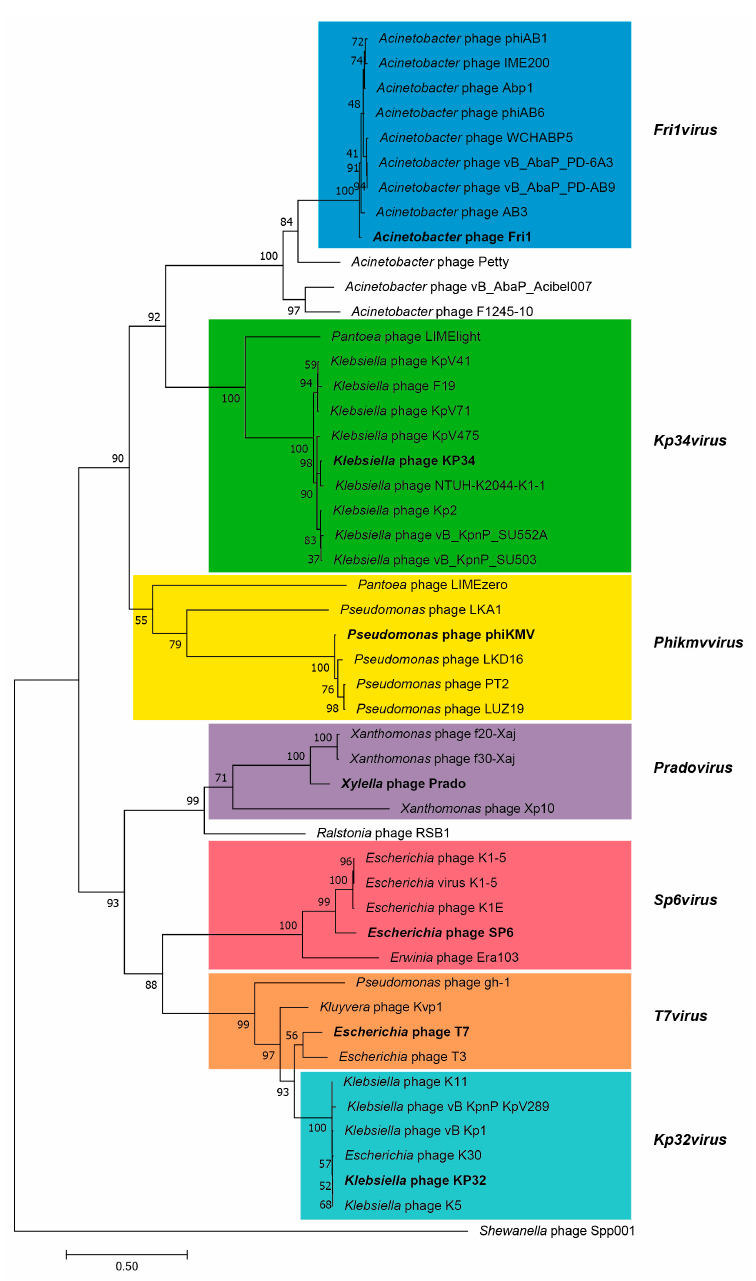
Figure 6. Neighbour-joining tree analysis of the DNA-dependent RNA polymerases of phages comprising ratified ICTV genera within the podovirus subfamily Autographivirinae . The tree was rooted using the RNA polymerase from Shewanella phage Spp001 [YP_009008879] as the out group. The phylogenetic tree was constructed using a MUSCLE alignment [97] and the maximum likelihood method in MEGA7 [98] with 2000 bootstrap replicates. The bootstrap percentages are shown next to each node. The scale represents the number of amino acid substitutions per site. Phage genera as defined in the ICTV 2016 virus taxonomy release are delineated by coloured blocks with the type species for each genus displayed in bold text.